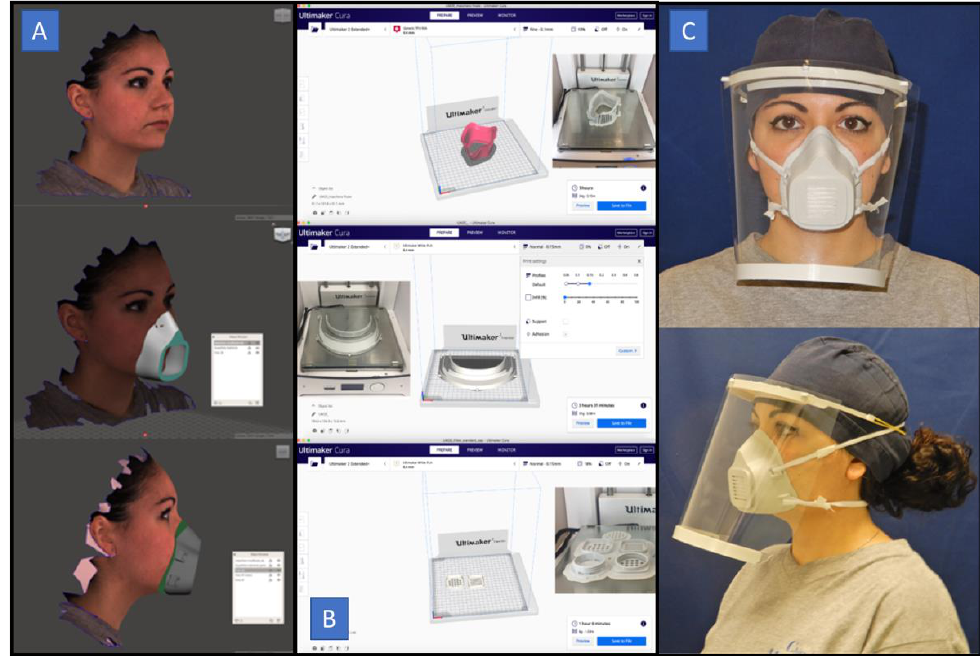
Figure 6. Editing phase and virtual design of the face mask ( A ), final virtual check of the COVID-19 pandemic kit ( B ), and a healthcare worker wearing the 3D-printed COVID-19 pandemic kit showing a perfect fitting of the device ( C ).